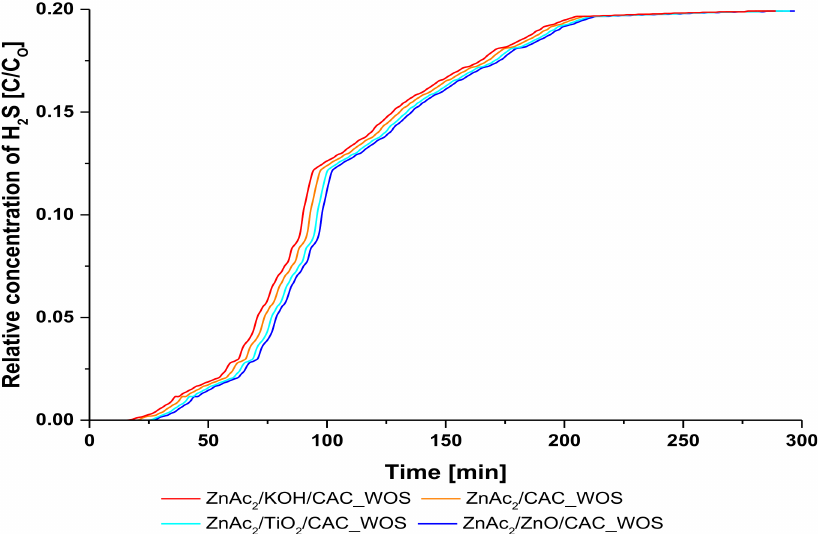
Figure 5. Relative concentration of H 2 S profile for CS/CAC_WOS adsorbents. The adsorbent material with the ZnAc 2 /ZnO/CAC core performs well compared to other core uses. Development of this ZnAc 2 /ZnO/CAC_WOS adsorbent showed the opti- mum H 2 S gas adsorption capacity at 1.17 mg H 2 S/g compared to ZnAc 2 /TiO 2 /CAC_WOS, ZnAc 2 /CAC_WOS and ZnAc 2 /KOH/CAC_WOS. However, the performance of